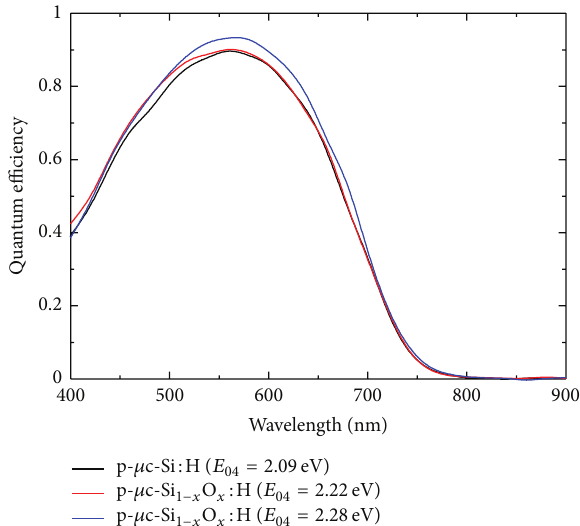
Figure 10: Quantum efficiencies of a-Si:H solar cells with p- 𝜇 c-Si:H and p- 𝜇 c-Si 1−𝑥 O 𝑥 :H layers.